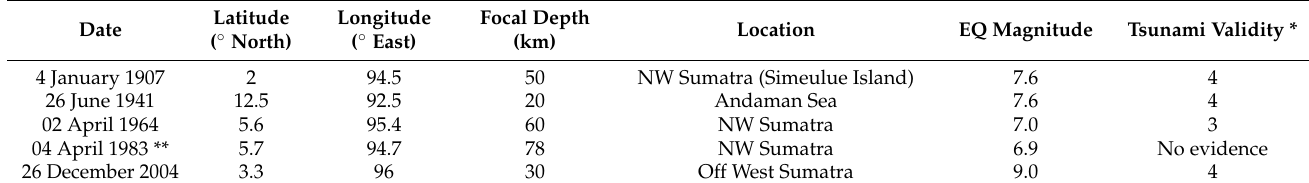
Figure 5. Regional earthquake occurrences at the northern Sumatra during the investigation period in the present study (1898–2017). The dashed-line rectangle shows the regional boundary of influence of the major (M ≥ 7.0) and moderate (6.5 ≤ M < 7.0) earthquake records. Records of earthquakes M ≥ 7.0 accompanied with the validity of tsunami occurrences are retrieved from the earthquake catalog by [54], and the tectonic earthquakes associated with the Great Sumatran Fault obtained from [55]. Table 2. Earthquakes leading tsunami events affecting Banda Aceh in the period of 1804 to 2004. Geographical boundaries displayed in Figure